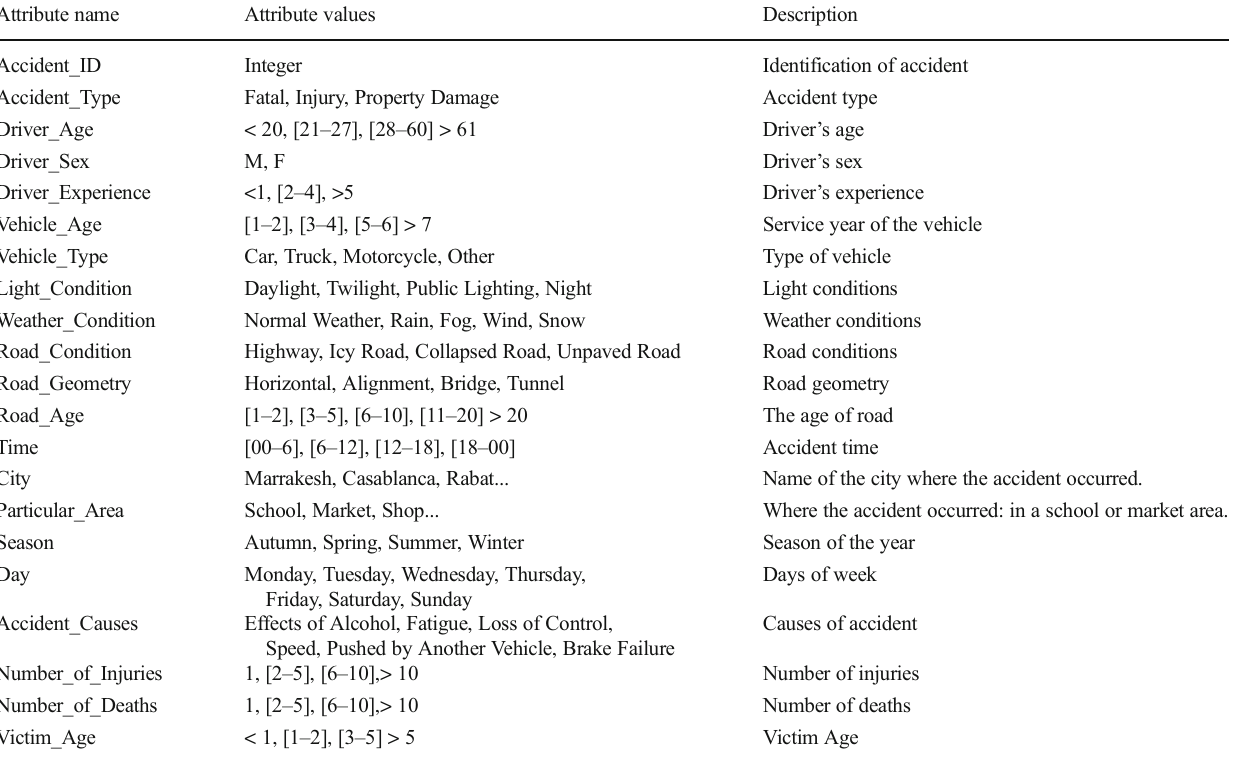
Road accident data attributes